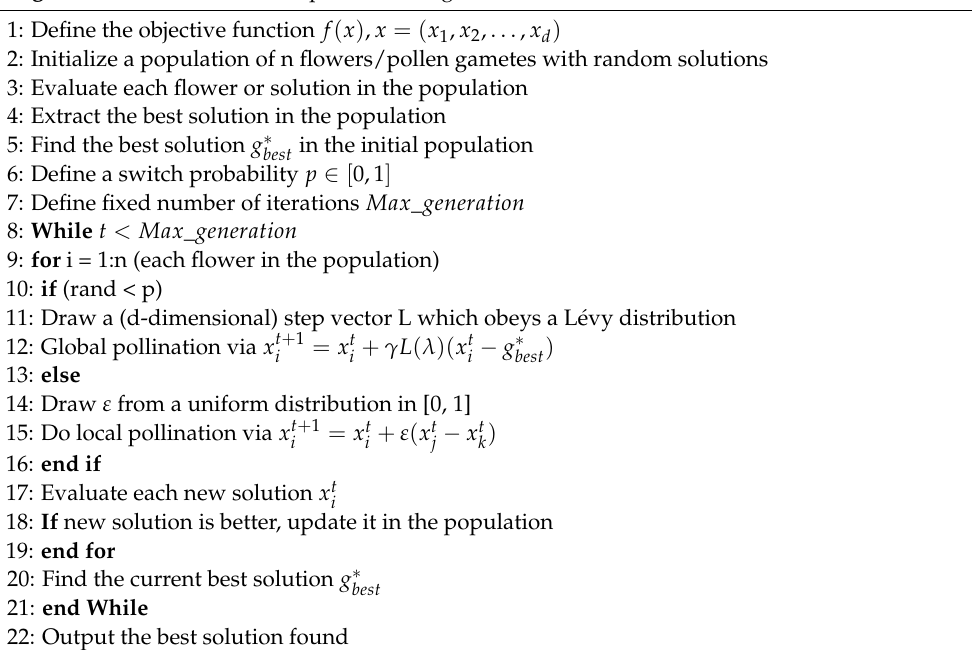
Algorithm 1. Standard flower pollination